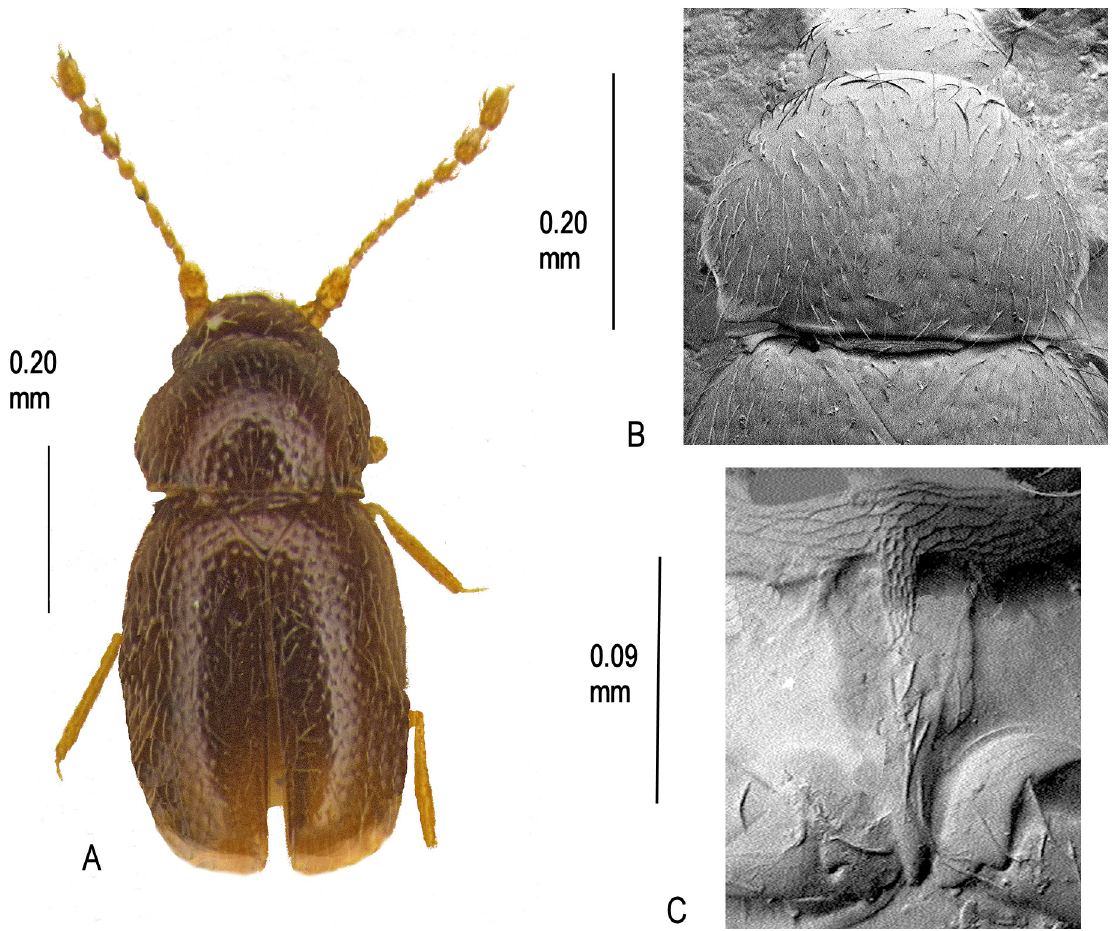
Fig. 77 . Cissidium opacum sp. nov. A . Habitus. B . Pronotum, × 550. C . Mesoventrite showing median process of collar, mid-keel and keel, ×